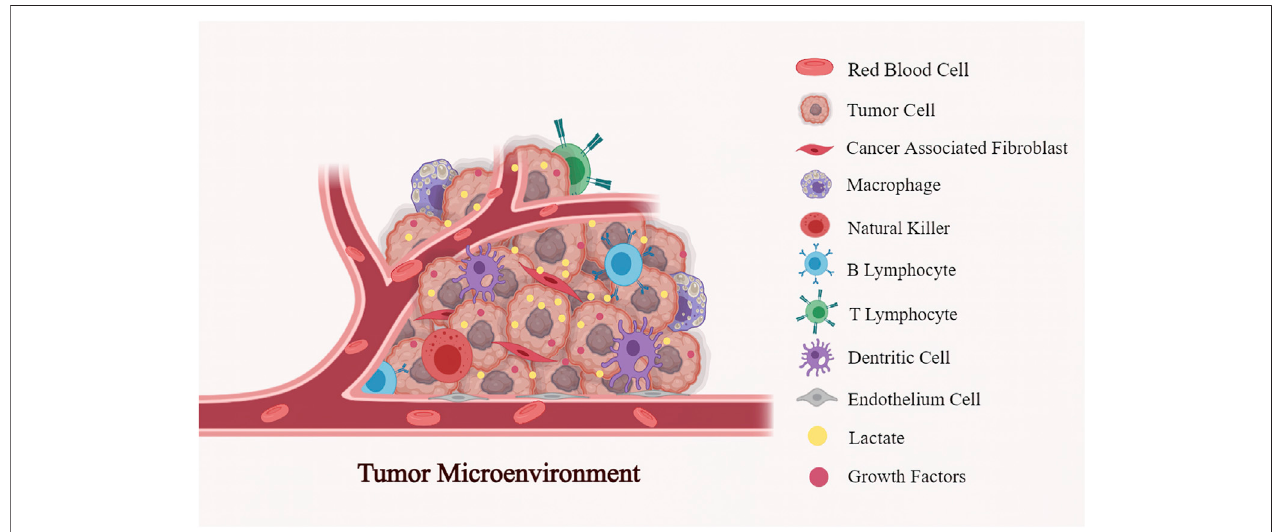
FIGURE 1 | The multiple components in the tumor microenvironment (TME): TME is a functional and structural niche composed of tumor cells, the surrounding tumorstromalcells(cancer-associated fi broblast(CAFs),mesenchymalstromalcells(MSCs),endothelialcells(ECs),andimmunecells(Tcells,Bcells,NKcells,dendritic cells, macrophages et al.). Being the primary metabilite in the tumor milieu, lactate involves in the interactions between cancer cells and stromal cells to reprogramme TME, further regulating the tumor evolution.